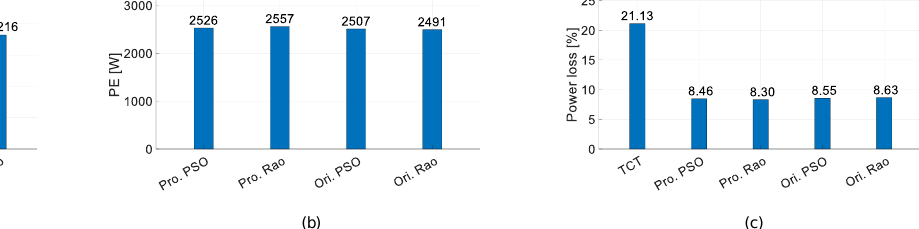
Figure 16. Comparison of performance metrics of PV array under the top edge of the cloud. ( a ) GMPP. ( b ) PE. ( c ) PL.